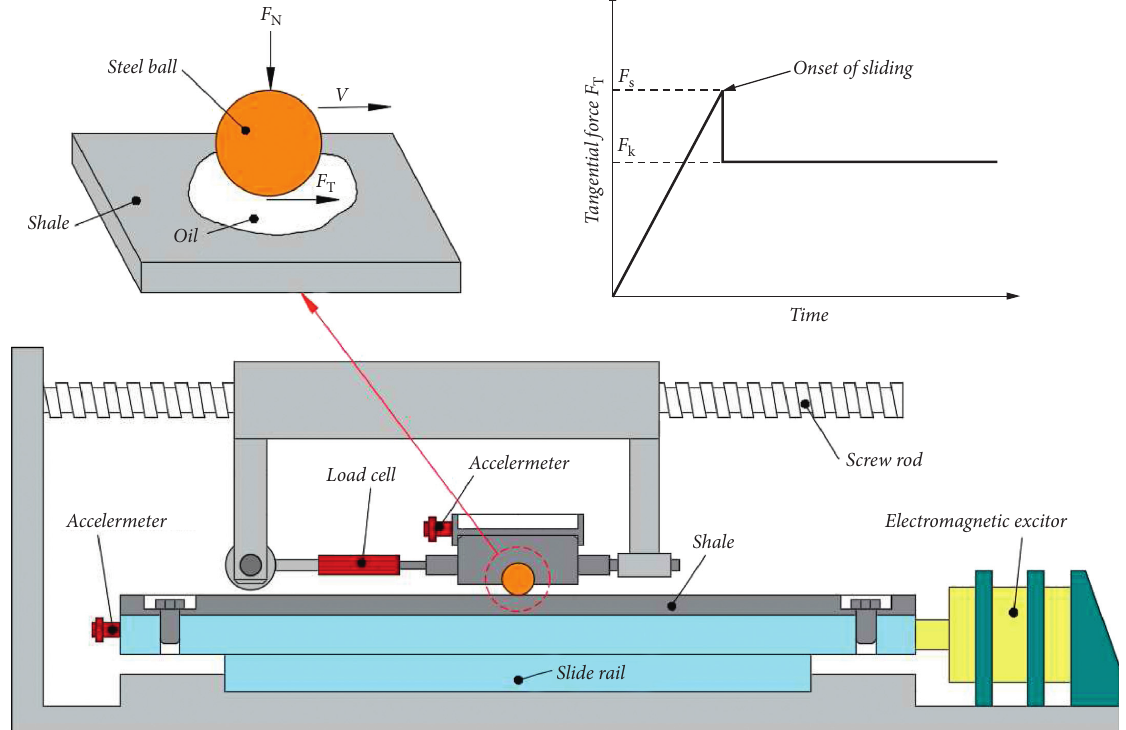
Figure 1: Experimental setup and a hypothetical static to kinetic friction transition